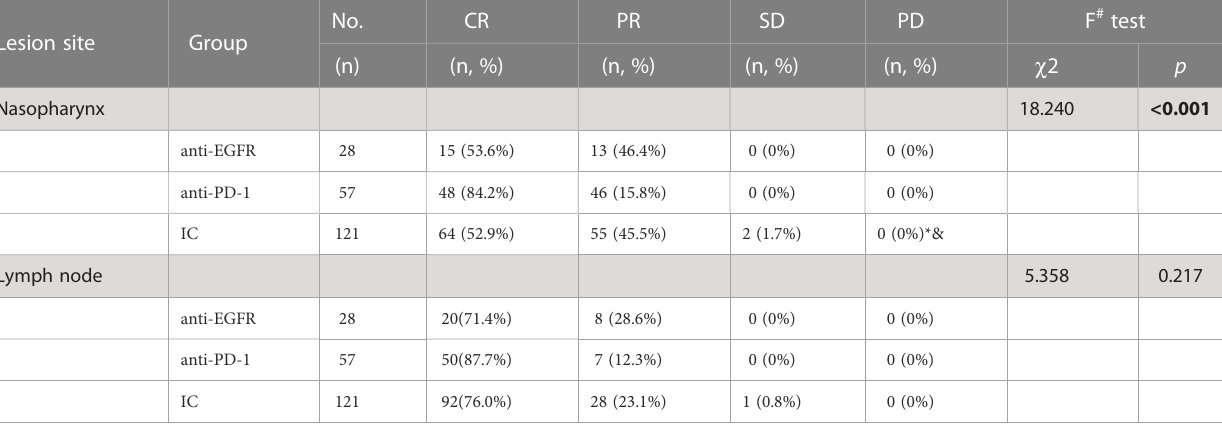
TABLE 5 Short-term ef fi cacy after overall treatment.